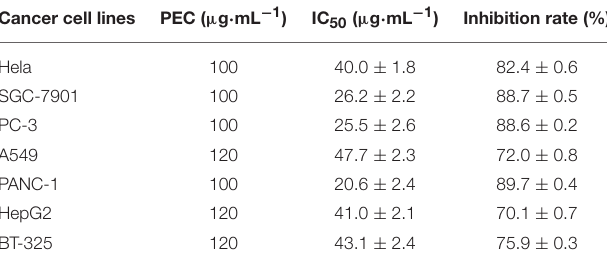
TABLE 3 | Inhibitory effect of PEC on cancer cells after 72h ( ¯ x ± s, n =